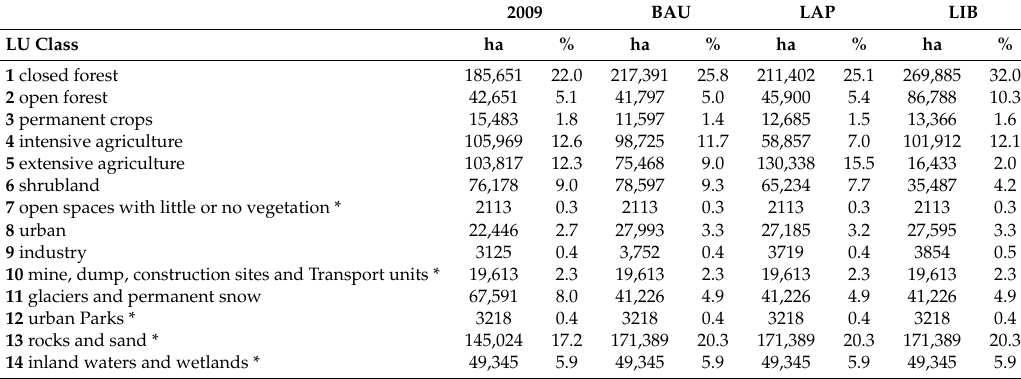
Table 6. Total area (ha and %) each LU class occupies in the observed 2009 dataset and in each scenario in 2050. * Classes that were not modelled and, thus, considered static